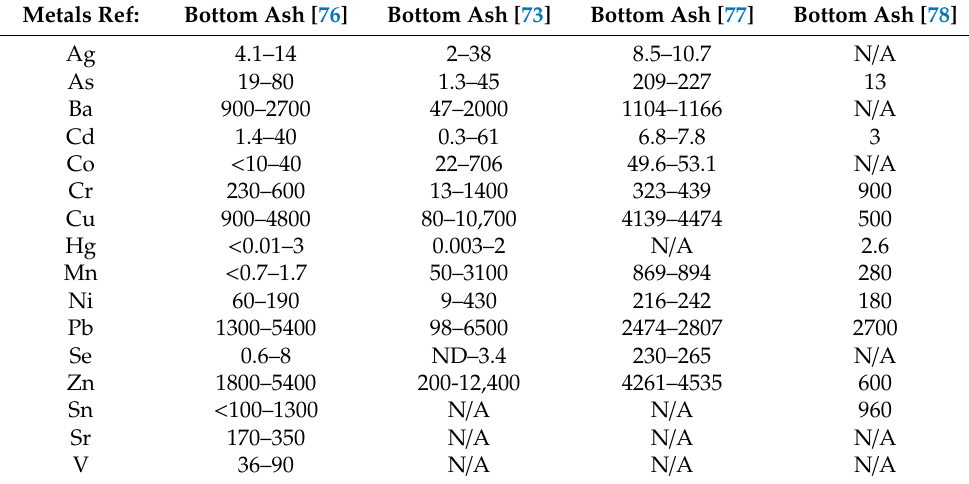
Table 5. Heavy metal content (mg / kg) MSWI bottom ash